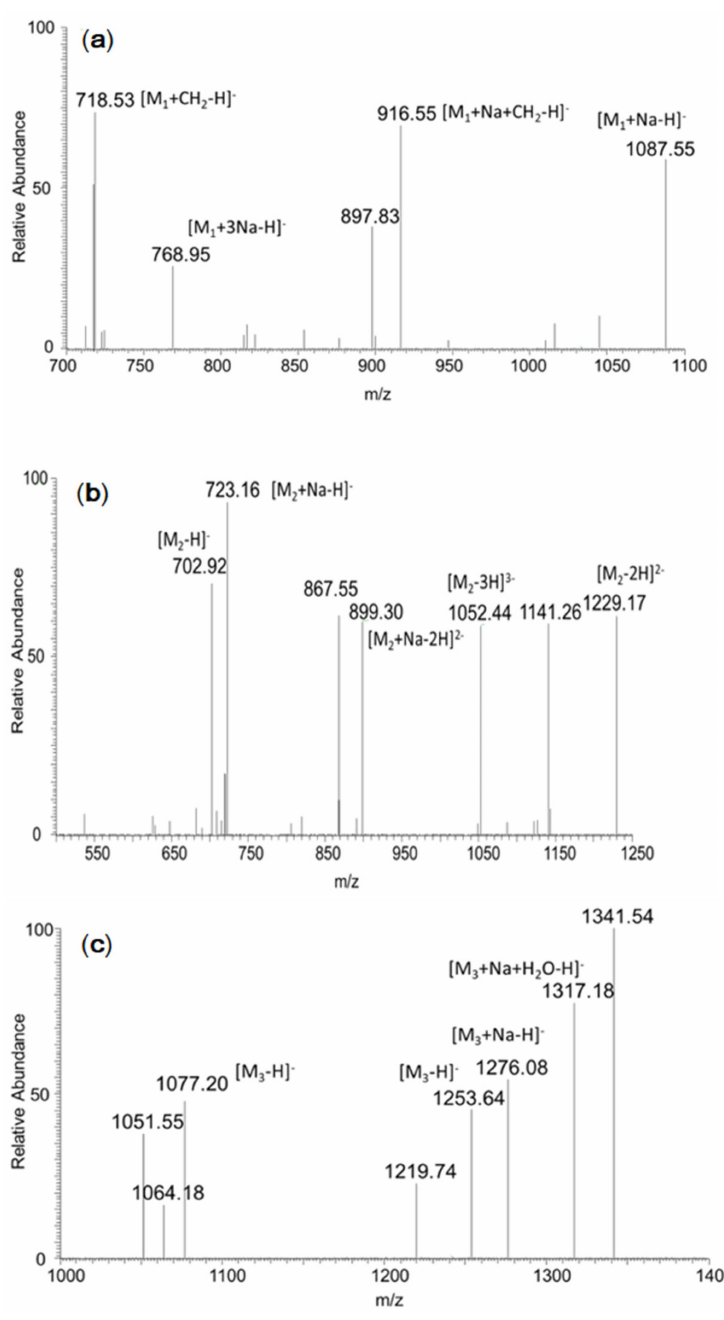
Figure 1. MS spectra of MOS-Sia. ( a ) MOS-Sia1, ( b ) MOS-Sia2, and ( c )